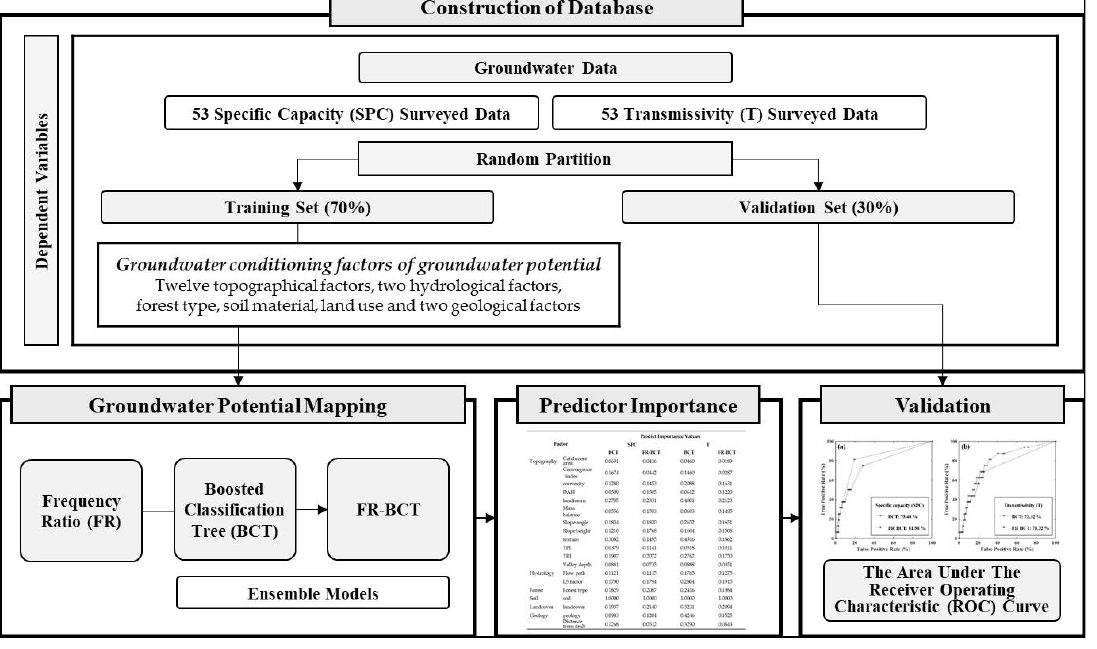
Figure 5. Data flow of this